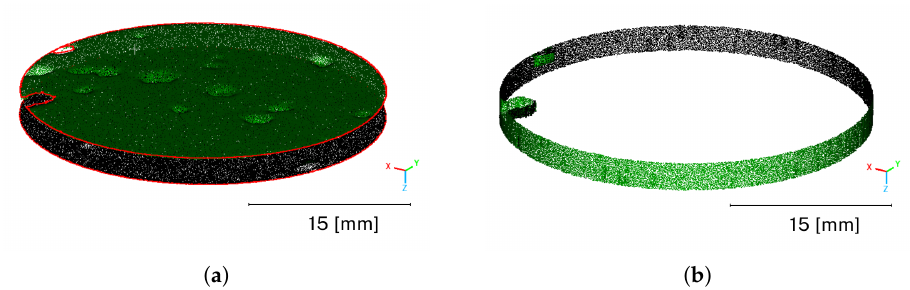
Figure 8. The perimeter lines fitted in the top and bottom of slice ( a ) and the reconstructed circumfer- ence ( b ) of slice no. 7.